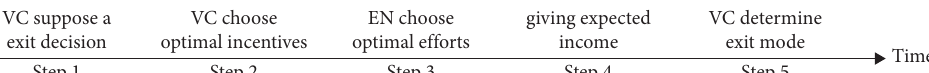
Figure 2: The timeline of a venture